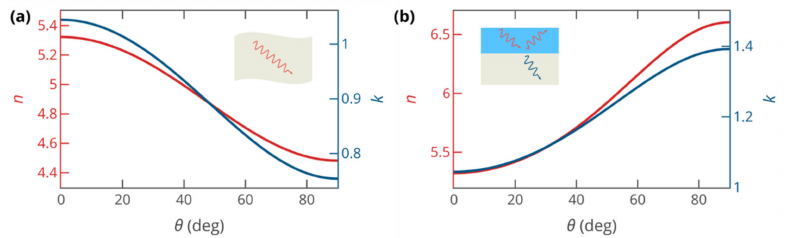
Figure 2. Effective refractive indices of the anisotropic MoS 2 layer, governing: ( a ) phase accumulation and field attenuation upon propagation of a p-polarized wave ( n eff = β / β 0 ) and ( b ) reflection and transmission of a p-polarized wave at interfaces with other materials, calculated from Equation (5). At an angle θ = 66 ◦ corresponding to the minimum reflectance, the effective refractive indices n p = 4.63 + 0.81 i and n i = 6.29 + 1.32 i differ from the in-plane refractive index by eff eff